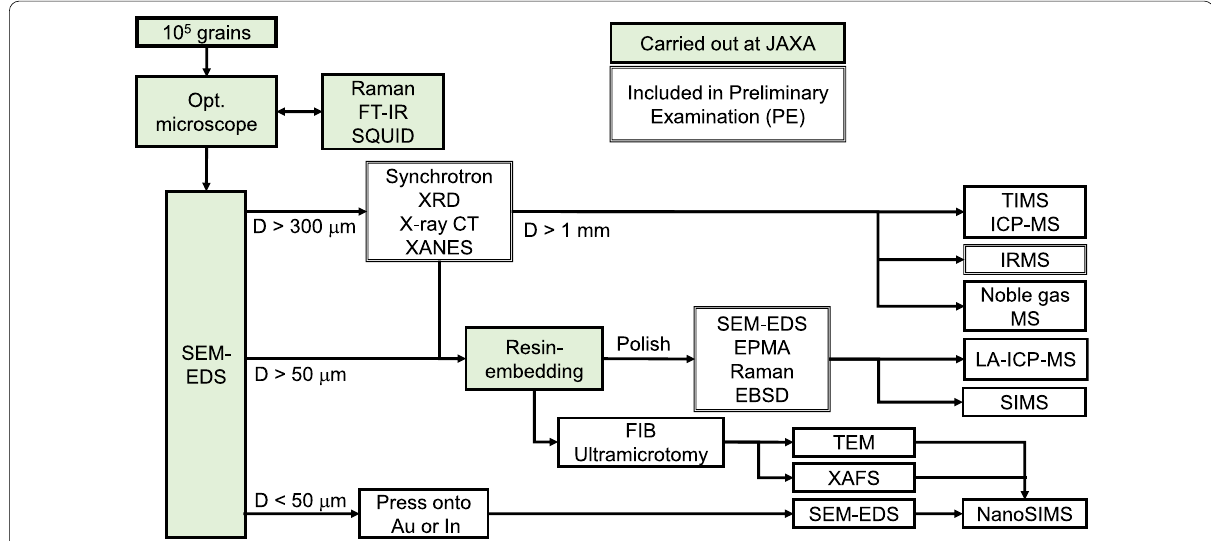
Fig. 6 Working flow of inorganic analyses. Analyses that will be included in PE are shown by double‑line